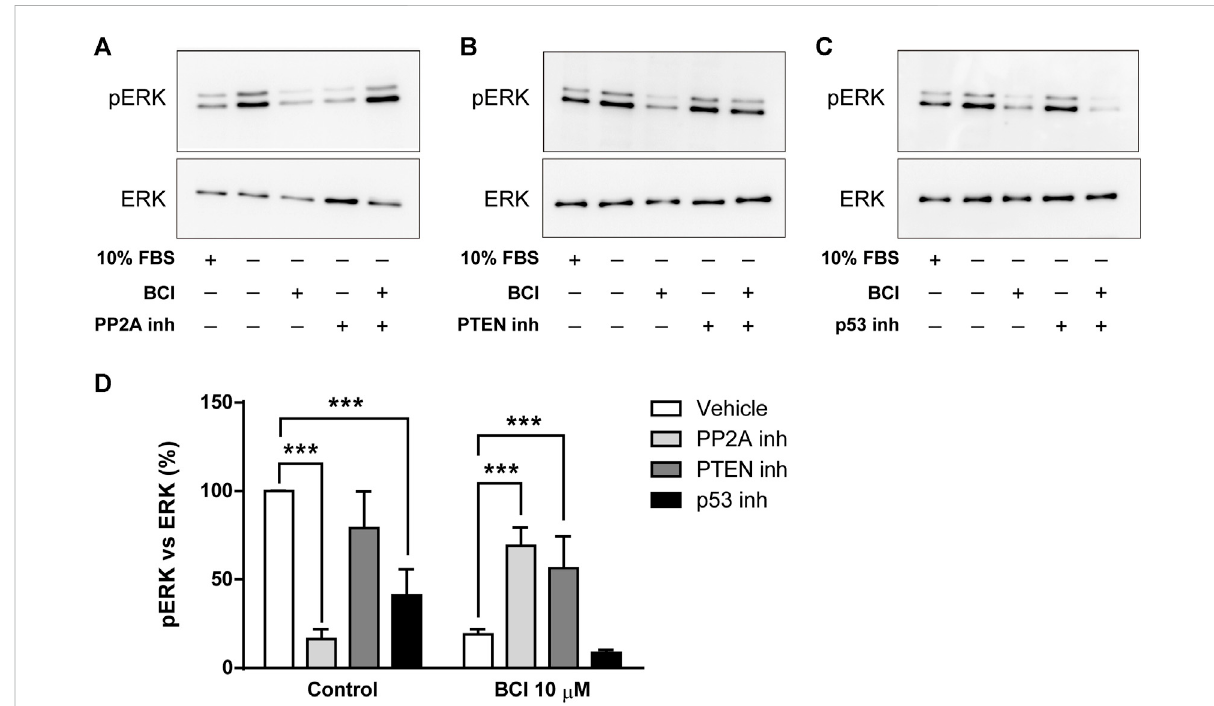
FIGURE 6 TheinhibitionofPP2AorPTENpreventsthedephosphorylationofERK1/2exertedbyBCIinneuroblastomacells.N2acellsculturedinSFMwere treated with inhibitors of (A) PP2A (1 μ M, okadaic acid), (B) PTEN (500 nM, VO-OH pic) or (C) p53 (20 μ M, cyclic pi fi thrin- α ) for 10 min before the addition for 1 h of either BCI (10 µM) or the vehicle alone (control). Untreated cells cultured either in SFM or complete medium (10% FBS) were also analyzed.Allthecellextractswereanalyzedinimmunoblotstodetectphospho-ERK1/2andtotalERK. (D) Thehistogramshowsphospho-ERK1/ 2 protein levels obtained by densitometry and normalized to the total ERK. The phospho-protein levels where normalized to the levels in untreated cells cultured in SFM (set as 100%). The values represent the mean ± SEM of four independent experiments performed in duplicate. *** p ≤ .001 vs.